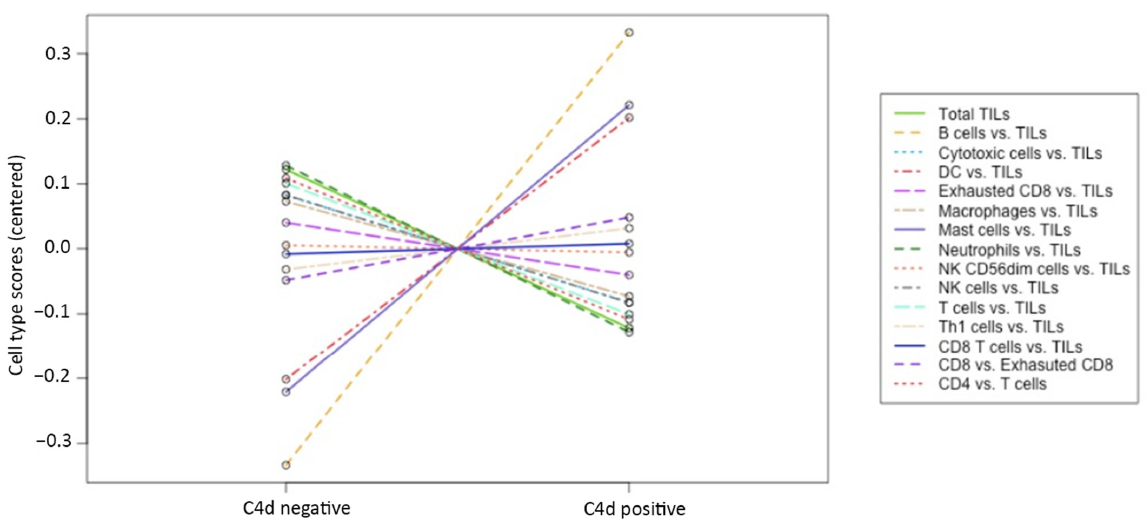
Figure 5. Inflammatory response. The plot represents the expression of gene signatures related to specific immune cell types comparing C4d positive versus C4d negative c-ABMR cases. Genes associated with B cell lymphocytes and mast-cells were more expressed in C4d positive cases, while genes related to T cell lymphocytes and NK cells were more expressed in C4d negative cases.